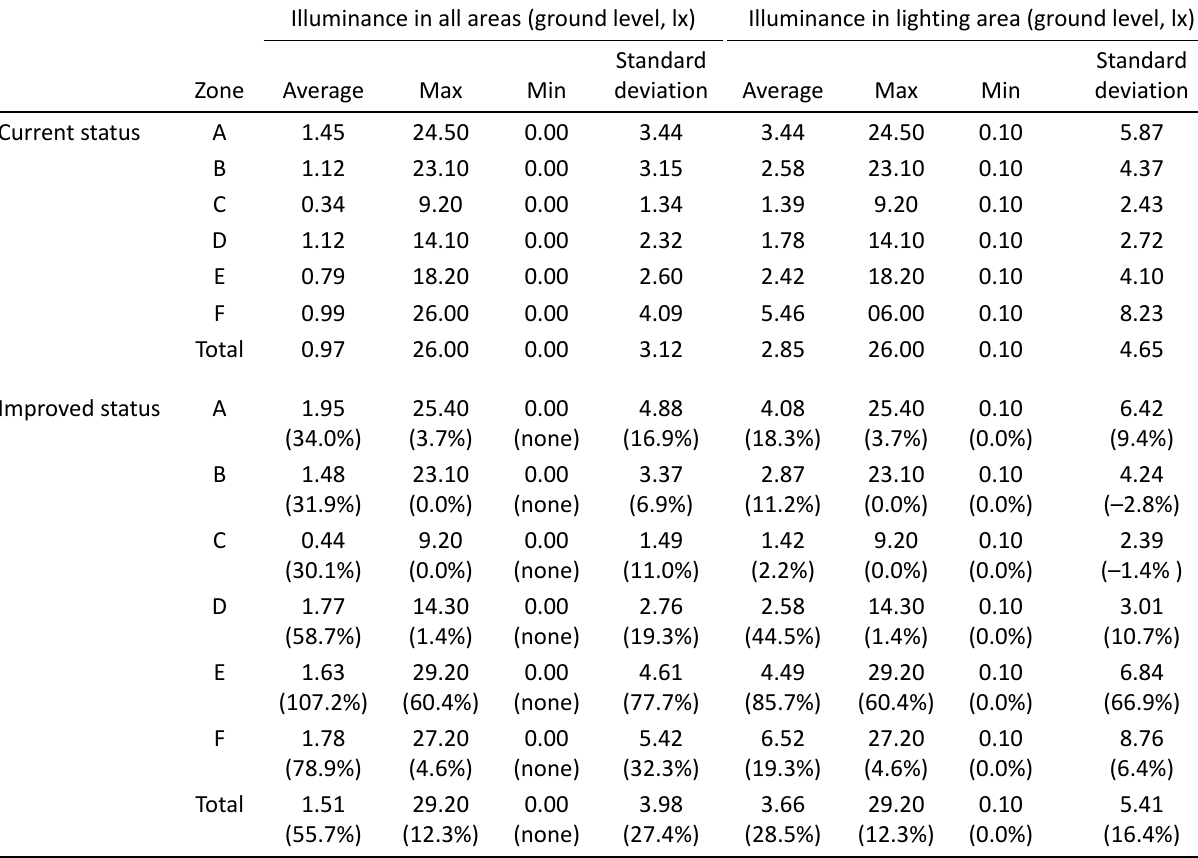
Table 3. Changes of zones’ illuminance of street lighting at ground